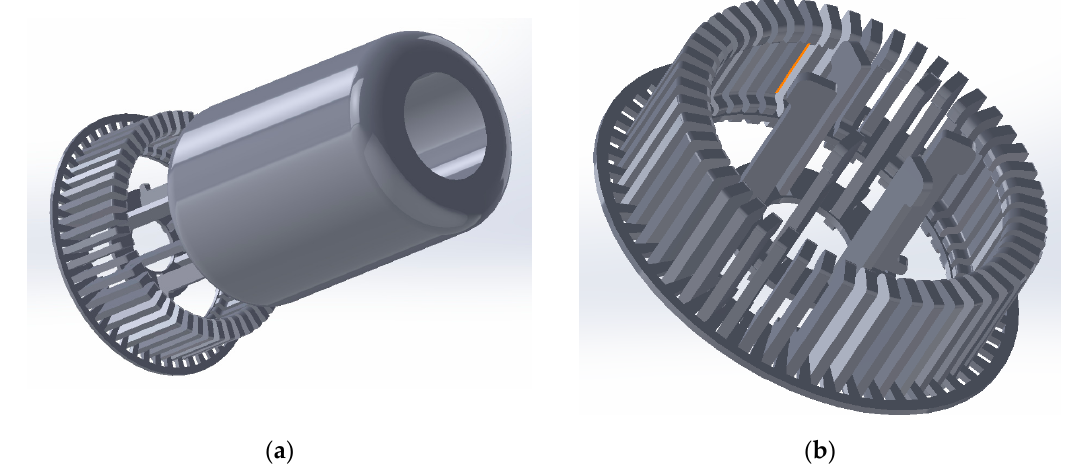
Figure 4. 3D model of the tulip contact: ( a ) View of a designed tulip contact model and ( b ) view of the lamellas in the tulip contact model. Table 1. Table of the material data used in the procured